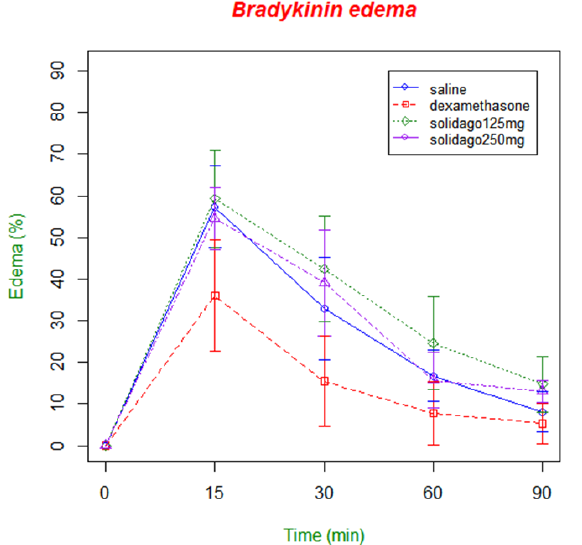
Figure 8. Variation in paw thickness percent 15 to 90 min after bradykinin administration. Animals were pretreated with vehicle (saline solution + 1% Tween 80, 10 ml/kg), dexamethasone 1 mg/kg, S. microglossa 125 mg/kg or S. microglossa 250 mg/kg 30 min before intraplantar injection of bradykinin (10 μg/paw). Edema was measured with a digital caliper at each time point marked. N=8 for all groups. Statistical analyses were performed between the treated groups and the group treated only with the vehicle at certain times (15 min, 30 min, 60 min, and 90 min). Analysis of variance (two-way ANOVA) followed by the Tukey’s multiple comparison of the means at the 95% familywise confidence level.